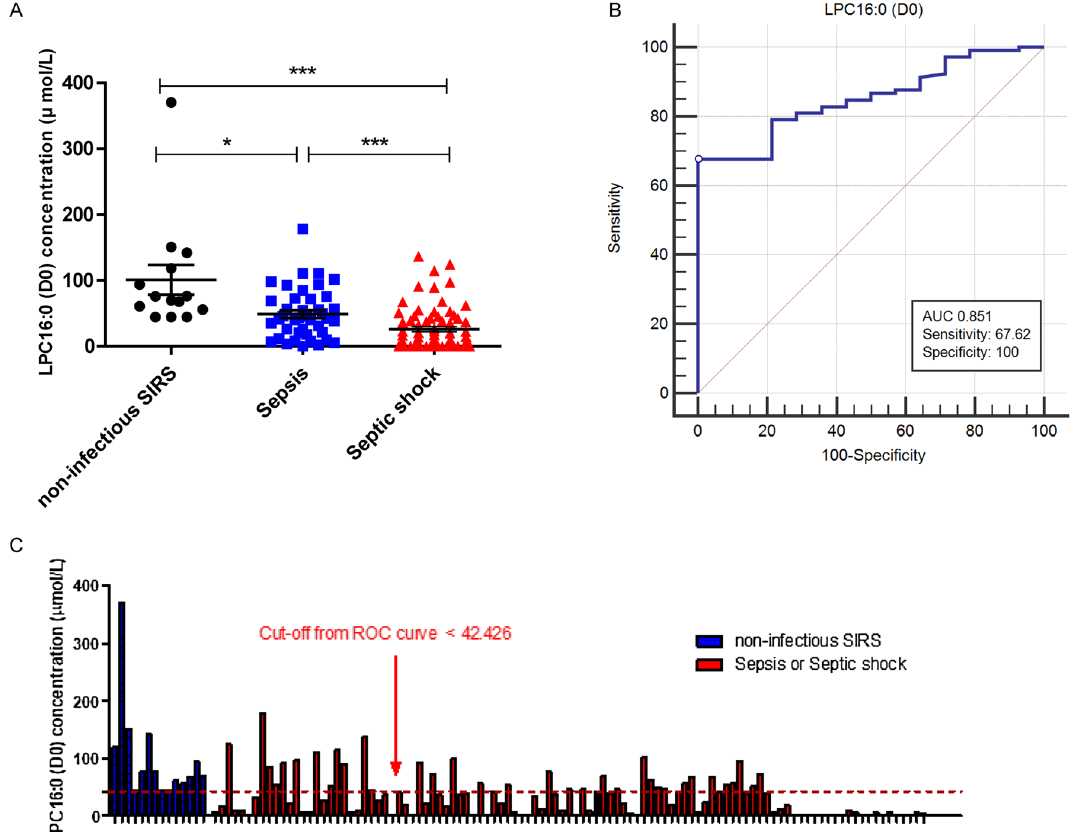
Figure 2. ( A ) LPC 16:0 (D0) concentration in patients with non-infectious SIRS (n = 14), Sepsis (n = 41) and Septic shock (n = 72). ( B ) ROC curve of LPC16:0 (D0) for diagnosis of sepsis. ( C ) Analysis results of the LPC16:0 (D0) concentration (µmol/L) from non-infectious SIRS (n = 14), sepsis and septic shock patients (n = 113). Data provided are the mean ± SEM, *P < 0.05, **P < 0.01 ***P < 0.001, analyzed by one-way ANOVA with Bonferroni’s post hoc test.